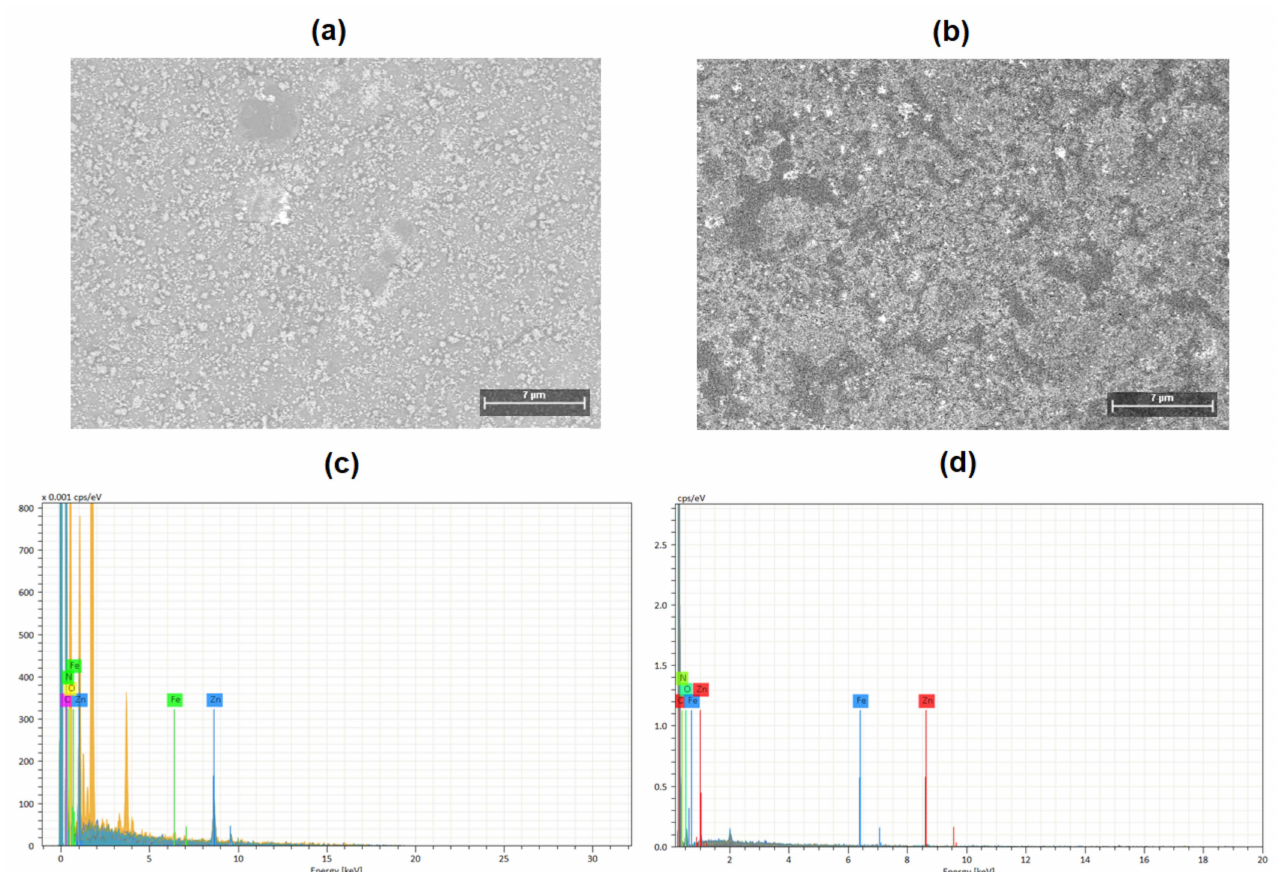
Figure 2. The SEM microphotographs for ( a ) FcPF 6 :DHAQ/ nylon(ZnPc) and ( b ) FcPF 6 :DAAQ/